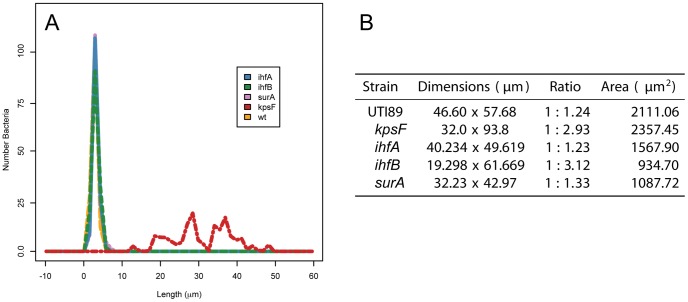
Quantitative Assessment of Intracellular Bacteria.The individual statistics of the bacteria growing within superficial mouse bladder epithelial cells as depicted in Figure 3 were determined. (A) The cell length of each bacterium was evaluated within individual images (NIH Image J) or 3-dimensional rendering [60]. The cell length distribution for each strain is represented. (B) The maximum dimension in the x and y axes, the ratio of the axes as well as the overall area of the intracellular bacteria were determined using Prokarymetrics.